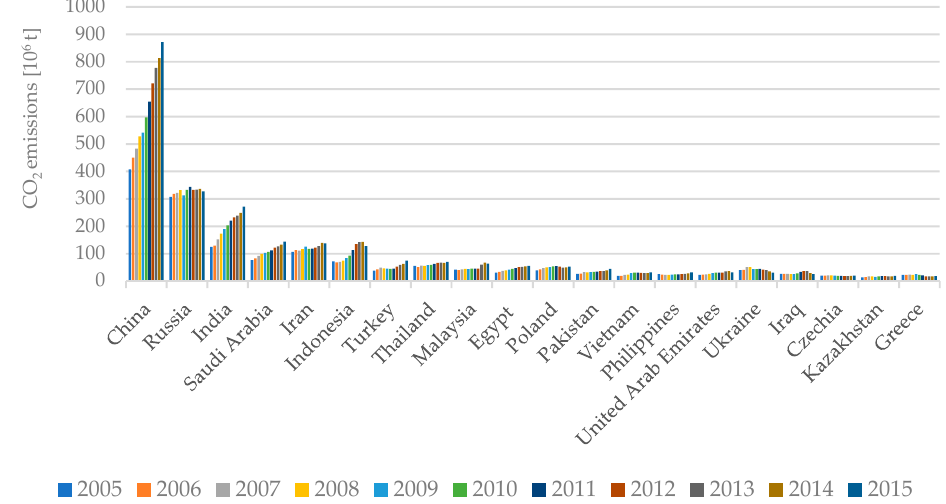
Figure 2. 2005–2015 BRI national transportation carbon emission.